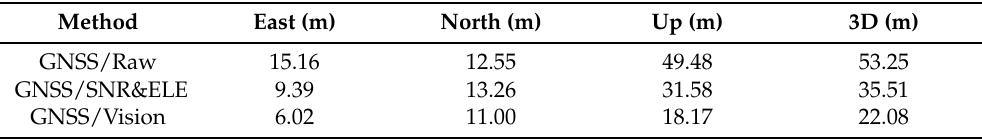
Table 2. RMS positioning results with different methods.